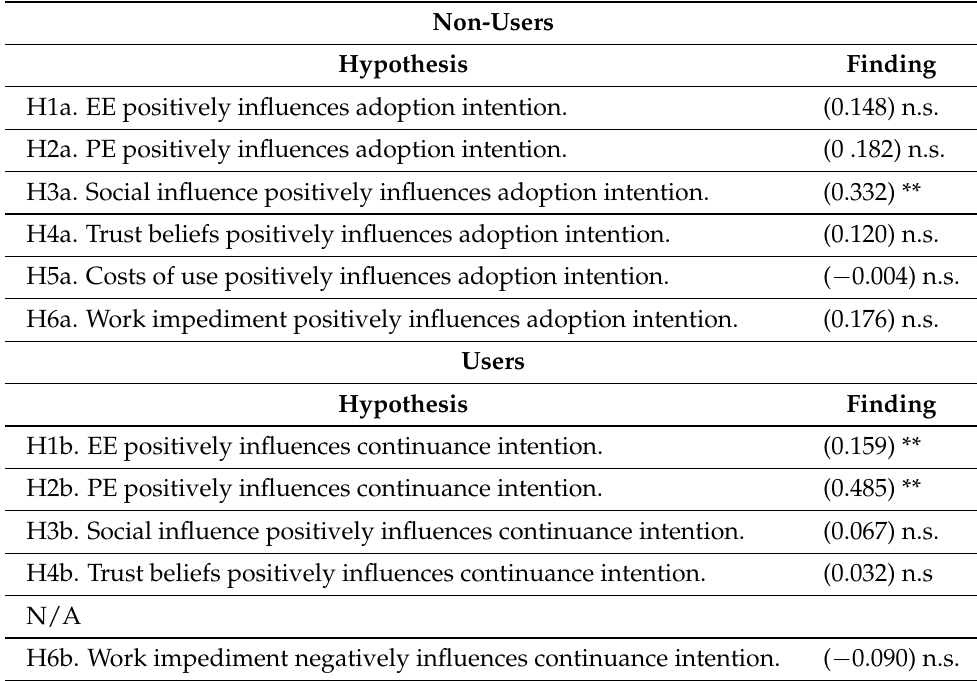
Table 3. Direct relationships.